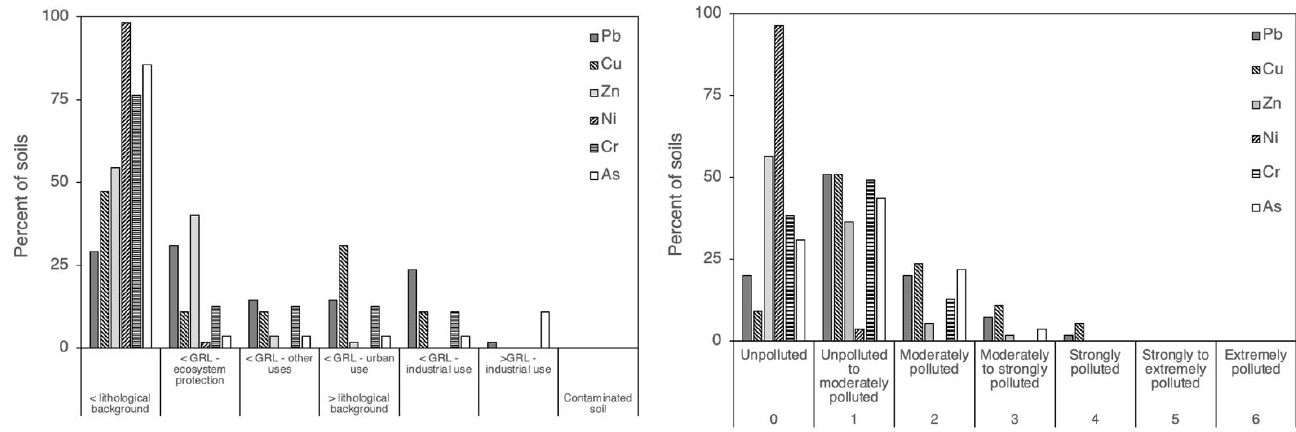
Figure 4. Left: IGeo summary results. Right: Comparison of concentrations in soils with the Generic Reference Levels (GRL) established in regulations